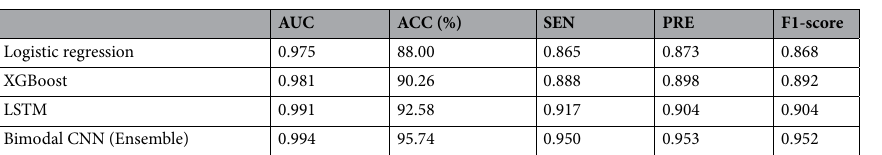
Table 4. Diagnostic performance comparison among logistic regression, XGBoost, LSTM and the proposed bimodal CNN model.